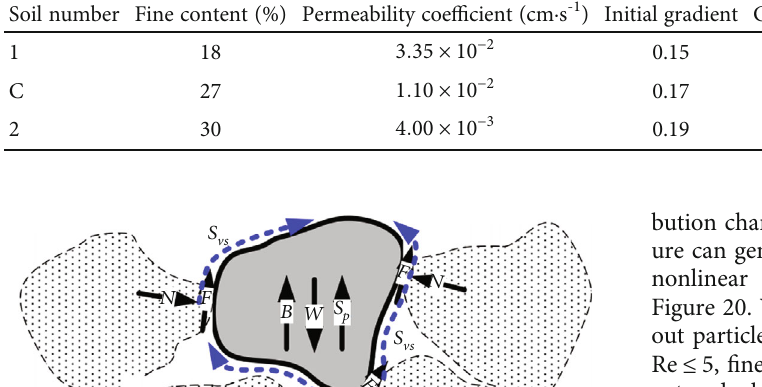
Table 4: Experimental results of di ff erent fi ne contents in sandy gravels.